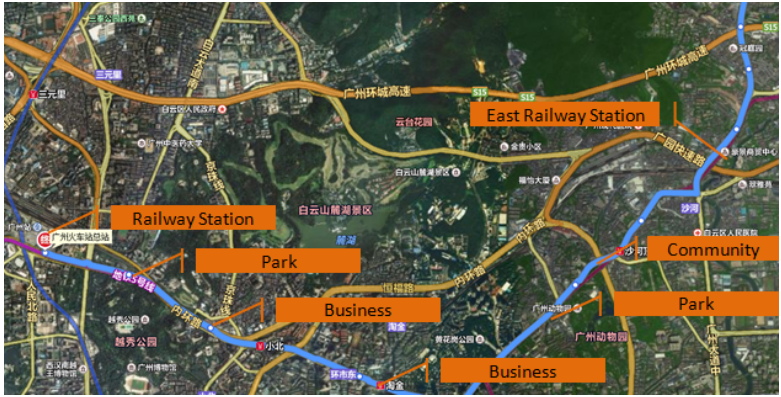
Figure 9. Potential reasons for taking the